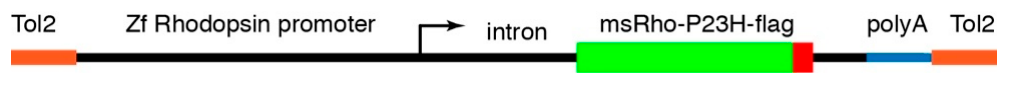
Figure 1. P23H mutant rhodopsin transgene construct. Mouse rhodopsin carrying the P23H mutation